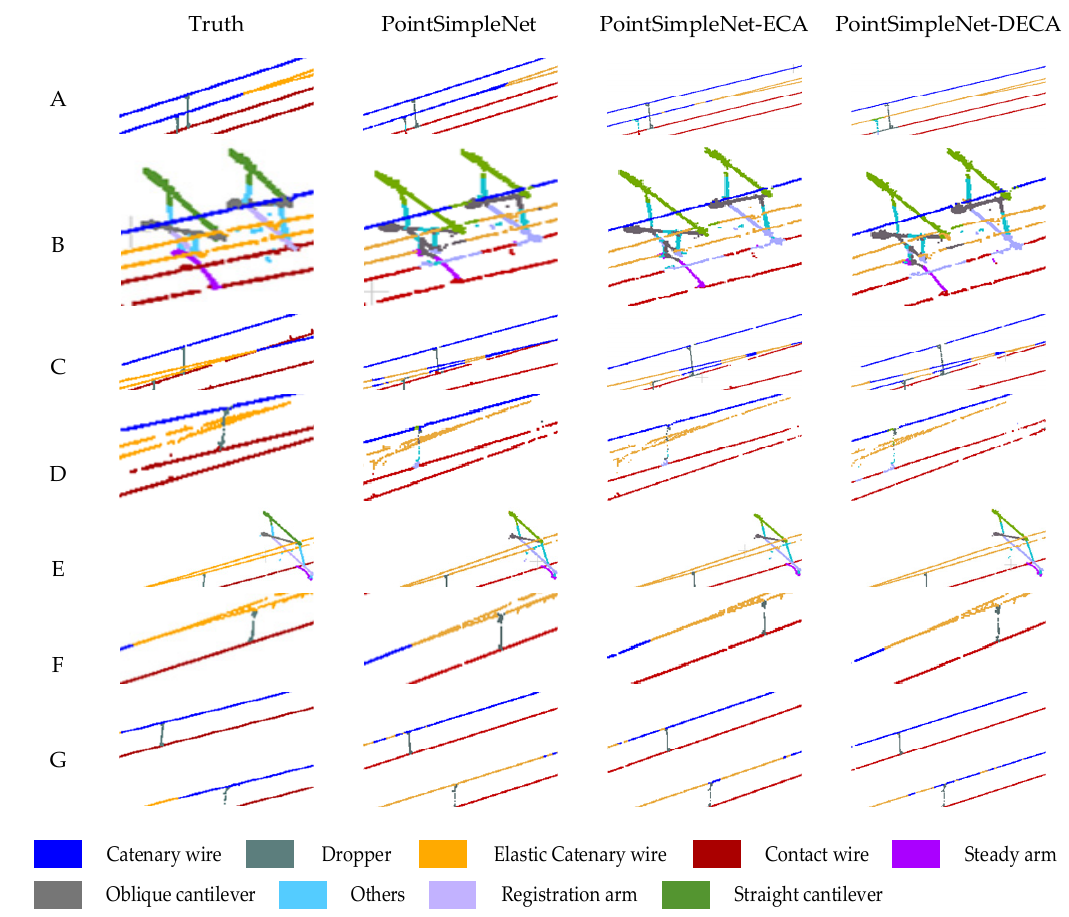
Figure 10. Comparison results of different attention mechanisms added to the basic frame. Column ( a1 – a4 ) and column ( b1 – b4 ) are global maps of double-arm and single-arm scenes, respectively. The range delineated in the red box is enlarged to present a more detailed visual comparison at the bottom, where A, B, C, and D are the ROI in the double-arm scene, and E, F, and G are the ROI in the single-arm scene.